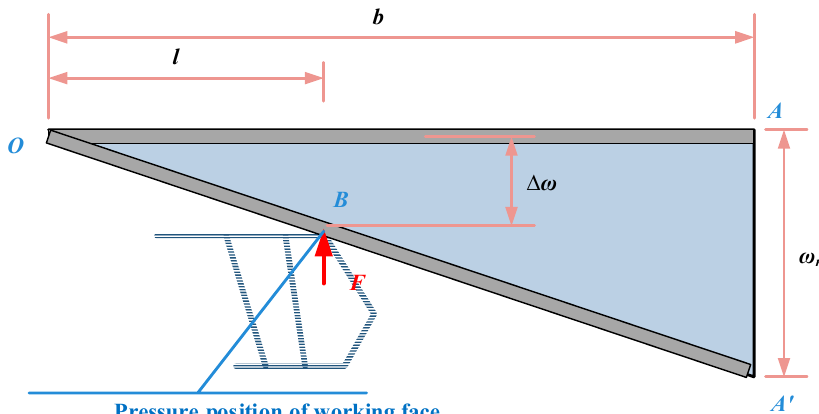
Figure 7. Main roof pressure sinking structure.